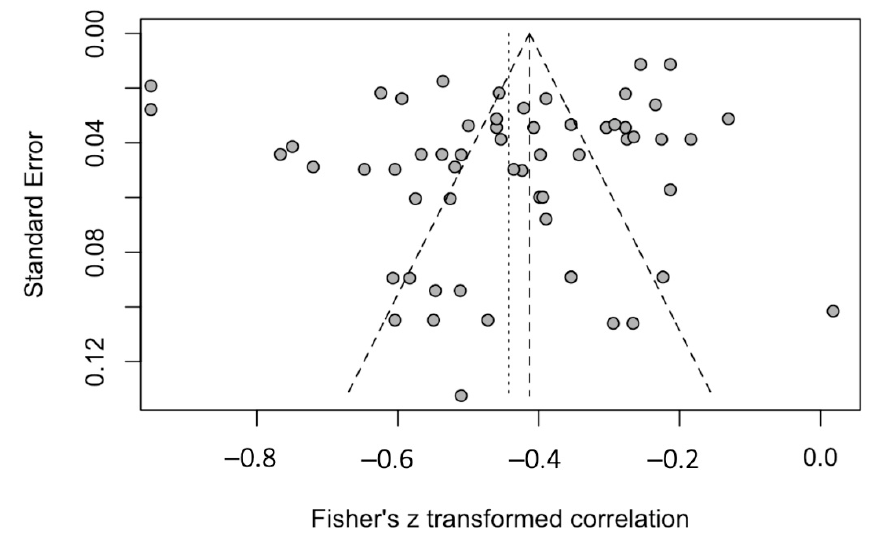
Figure 5. Funnel plot of effect sizes included in the meta-analysis.